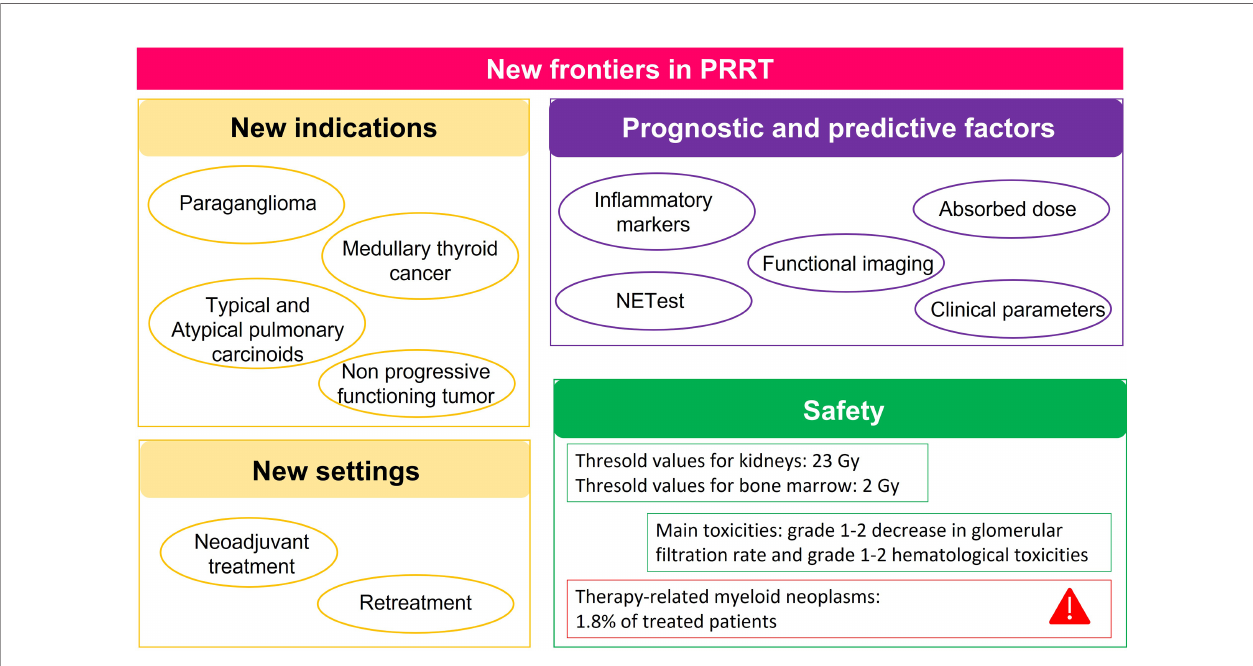
FIGURE 1 | Summary of the main fi ndings of articles published in 2021 on the 3 hot topics of peptide receptor radionuclide therapy (PRRT) in neuroendocrine tumors (NETs): new indications and settings, prognostic and predictive factors, and